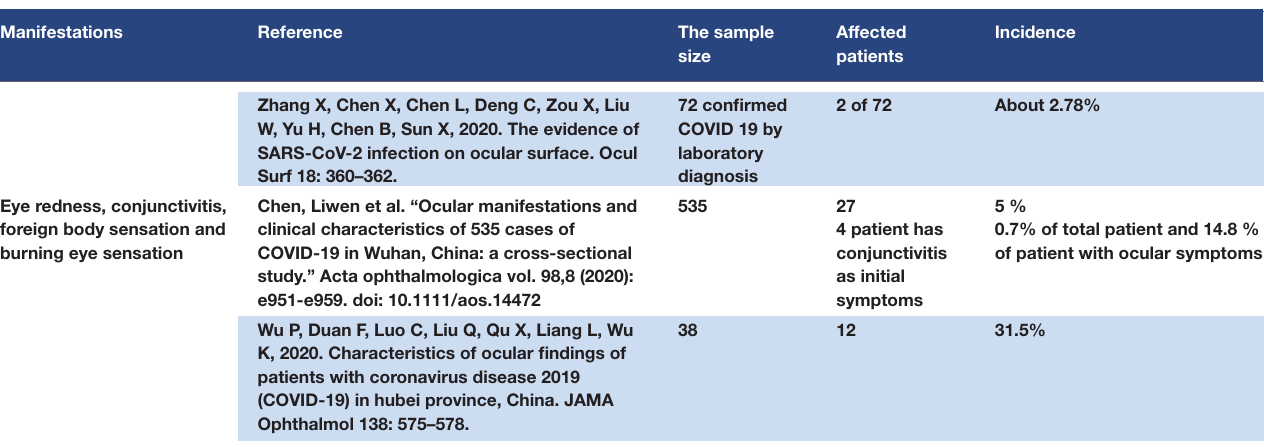
TABLE 8 | Ocular manifestations of COVID